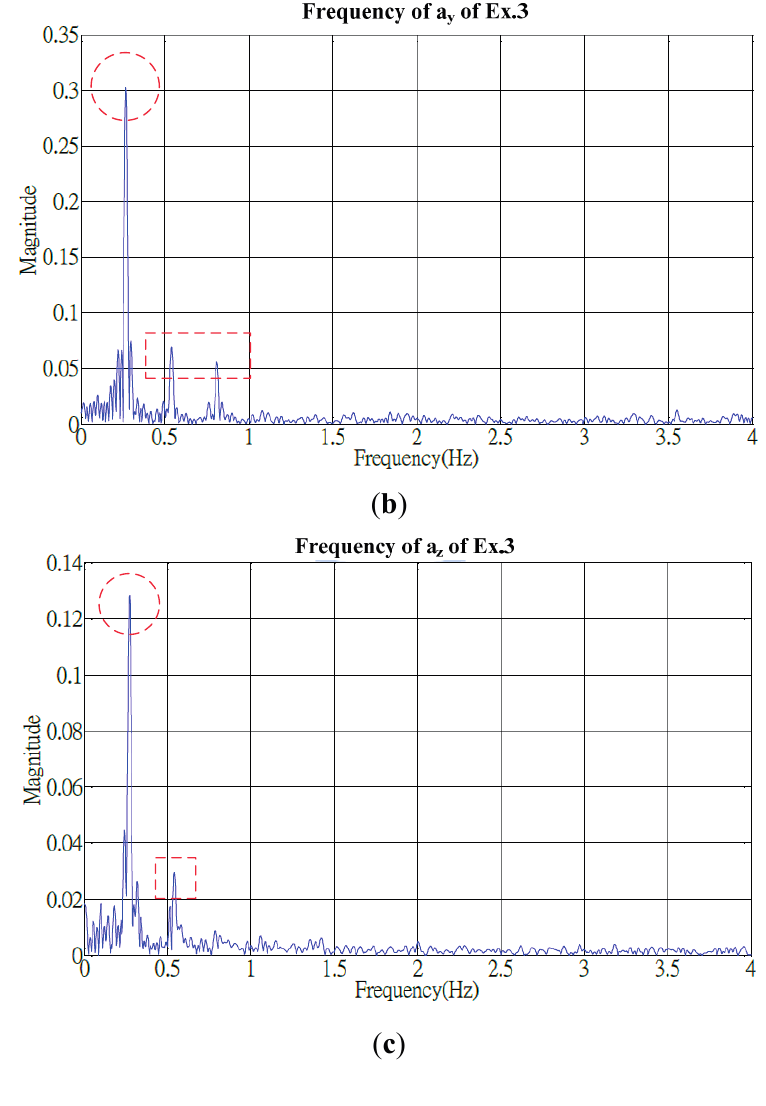
Figure 9. Frequency histogram of acceleration component of Ex.3 (finger wall-climbing exercise) in which their primary and secondary peaks are marked by circle and box in dash line. ( a ) Acceleration a x of Ex.3; ( b ) Acceleration a y of Ex.3; ( c ) Acceleration a z of